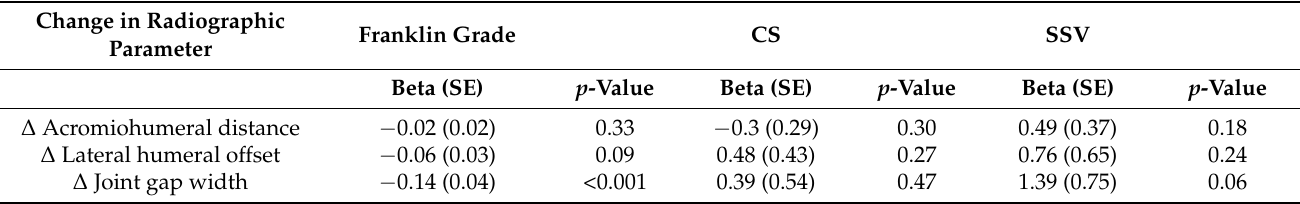
Table 4. Association between change in radiographic parameters ( ∆ from six months) and Franklin radiolucency grade, constant score, and subjective shoulder value (at one, two, and five years). Change in Radiographic